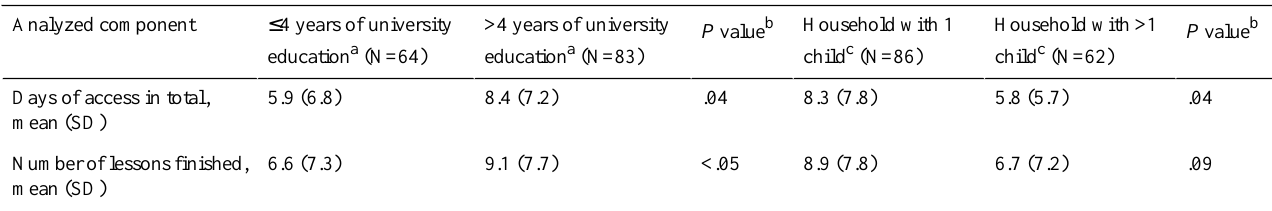
Table 3. Comparison of website use between education groups (N=147) and between 1-child and >1 child households (N=148).